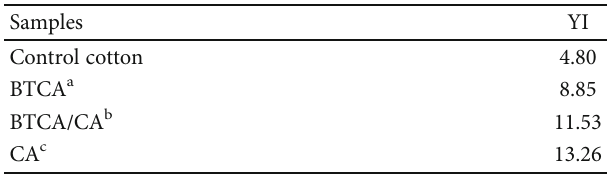
Scheme 2: Possible cross-linking between polycarboxylic acids and cellulose. Table 2: Yellowness index of fabrics treated with polycarboxylic